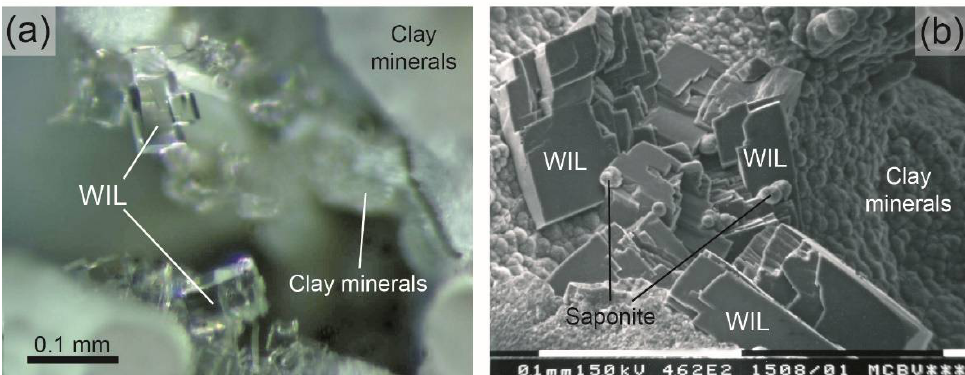
Figure 2. Willhendersonite from the Lessini Mounts: ( a ) stereomicroscopic image of colorless, transparent individual crystals of willhendersonite (WIL) associated to form small elongated clus- ters and grown on clay minerals; ( b ) SEM photomicrograph of willhendersonite twinned crystal aggregates (WIL) on a substrate of clay minerals with botryoidal shape and micrometric spherules of tri-octahedral saponite.